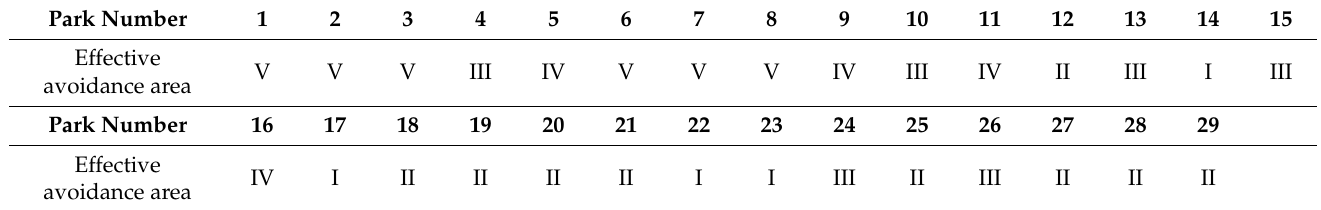
Table 9. The results of effective avoidance area assignment of country parks.